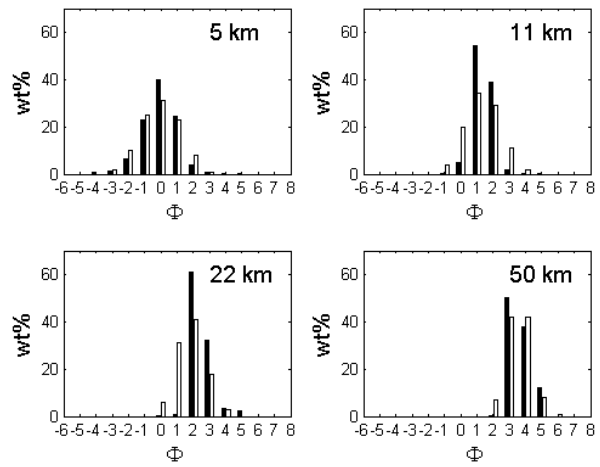
Fig. 3. Comparison between observed grain-size distribution of the tephra deposit (black) associated with the 22 July 1998 eruption of Etna (Andronico et al., 1999) and grain-size distribution (grey) computed at the same locations, Rifugio Sapienza, Tardaria, Sant’Agata Li Battiati and Agnone, respectively 5, 11, 22, and 50km from the volcanic vent.